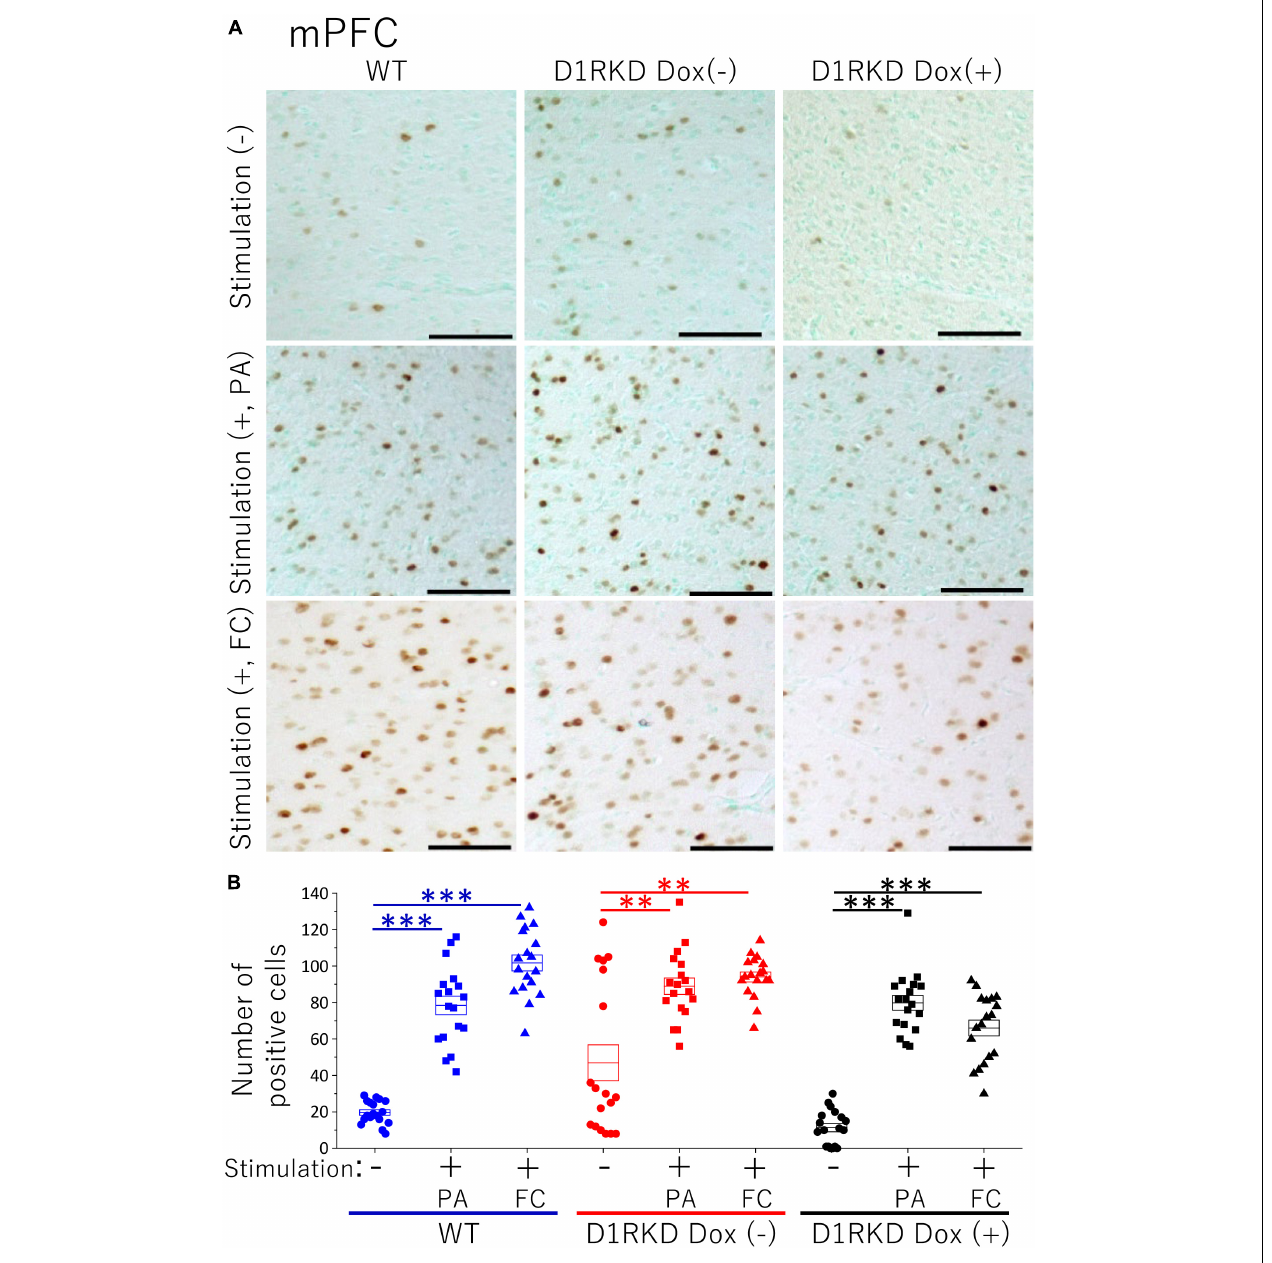
FIGURE 6 | Immunohistochemical analysis of c-Fos expression in mPFC after 1 h of electric footshock stimulus using a step-through-type apparatus for the passive avoidance test (PA) or fear conditioning system (FC). (A) Representative immunohistochemical staining of c-Fos positive cells. Scale bar, 100 µ m. (B) The number of positive cells in mPFC in immunohistochemistry. All groups, n = 18. The blue color indicates the values of WT groups, the red color indicates the values of D1RKD Dox (–) groups, and the black color indicates the values of D1RKD Dox (+) groups. The circle, square, and triangle indicate no stimulation, stimulation by PA, and stimulation by FC, respectively, ∗∗ p < 0.01; ∗∗∗ p <